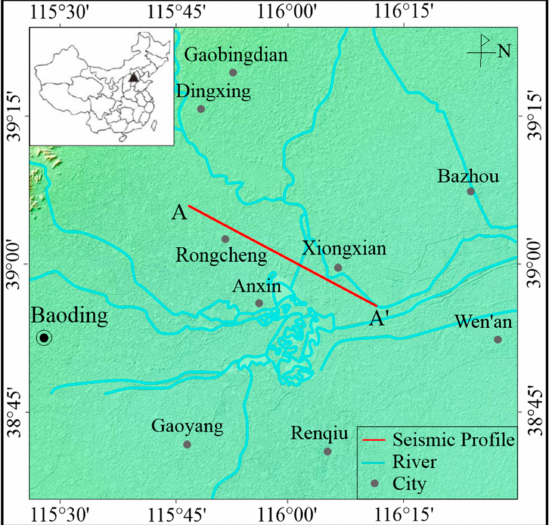
Figure 15. The seismic survey in Xiong’an New Area (modified according to [31]). The black triangle (cid:78) represents the location of Xiong’an New Area in China, and the red line represents the seismic profile AA’.